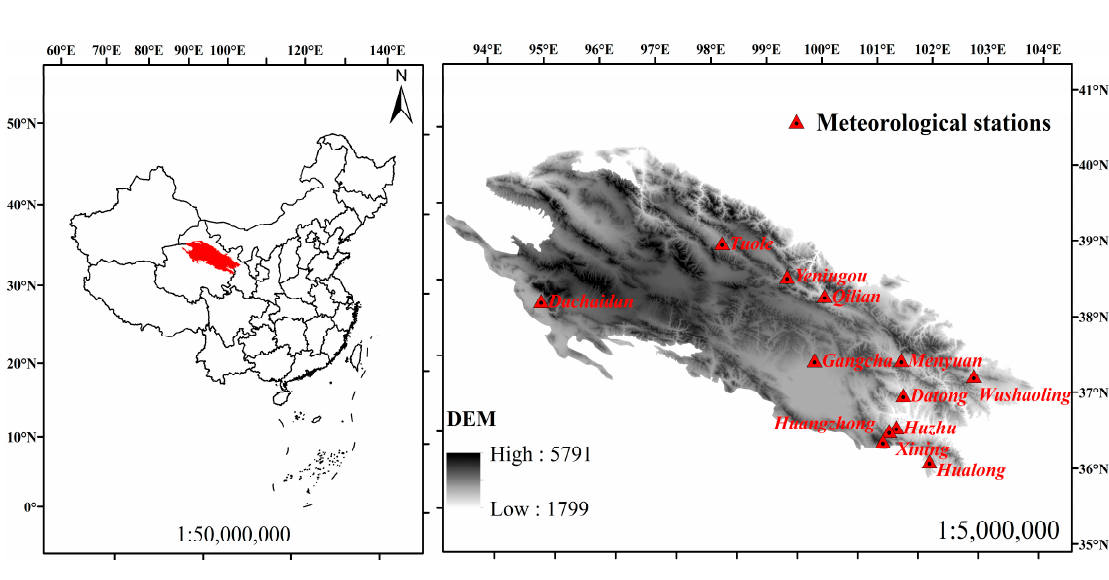
Figure 1. Study area and locations of meteorological stations used in the study in the Qilian Mountains.